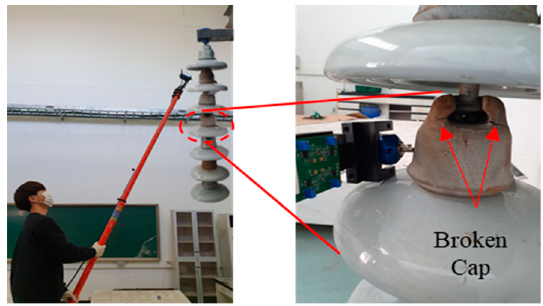
Figure 3. F requency response function (FRF) test method using developed equipment.